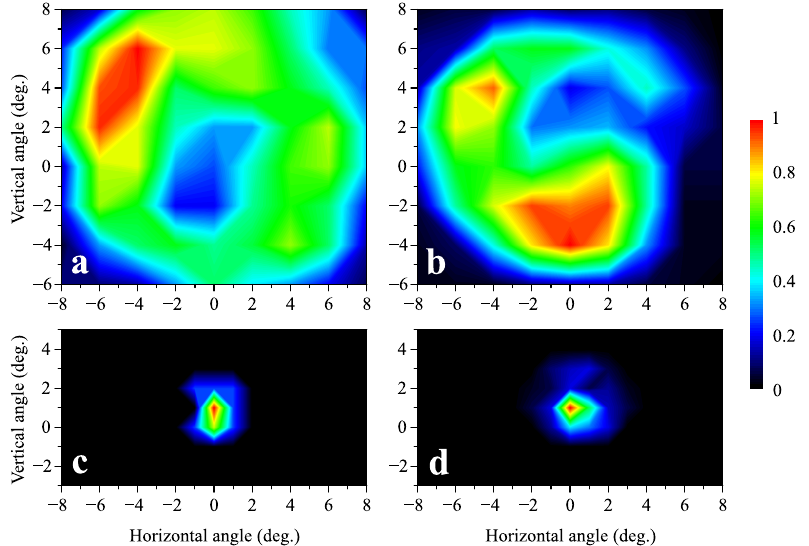
Figure 2. Normalized angular distributions of the radiation with frequencies of 0.5 THz ( a , c ) and 1 THz ( b , d ), without ( a , b ) and with ( c , d ) the polypropylene pipe. Focal length is 1 m, laser pulse energy is 3